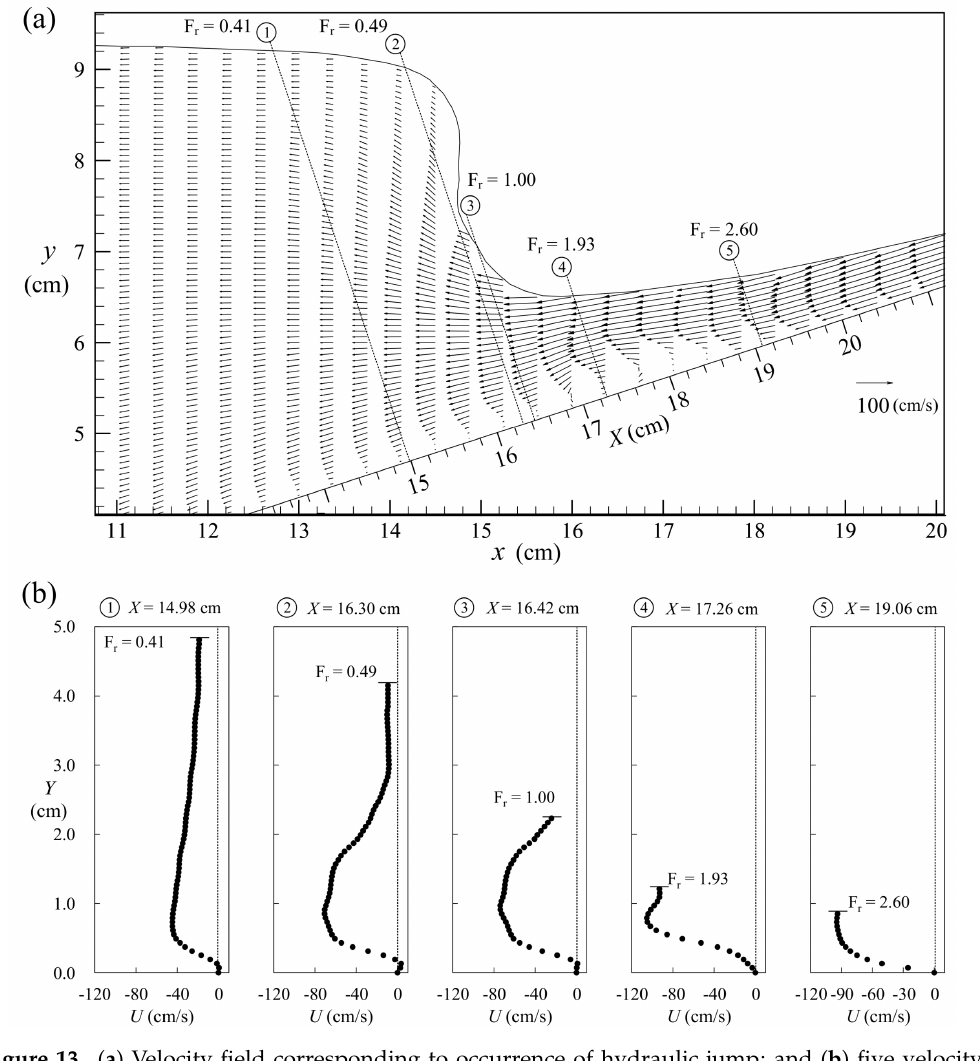
Figure 13. ( a ) Velocity field corresponding to occurrence of hydraulic jump; and ( b ) five velocity profiles U ( Y ) extracted from ( a ) and marked with values of Froude number for t = 1.007 s (Case